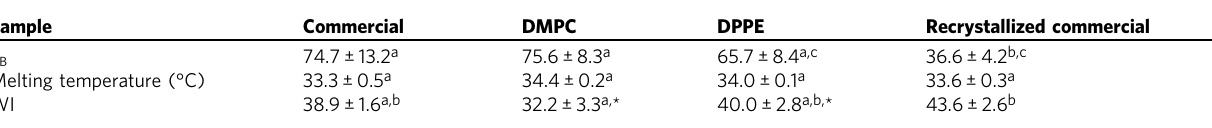
Table 2 Elastic bending modulus (E B ), melting temperature, and whiteness index (WI) of commercial chocolate samples with added phospholipids.